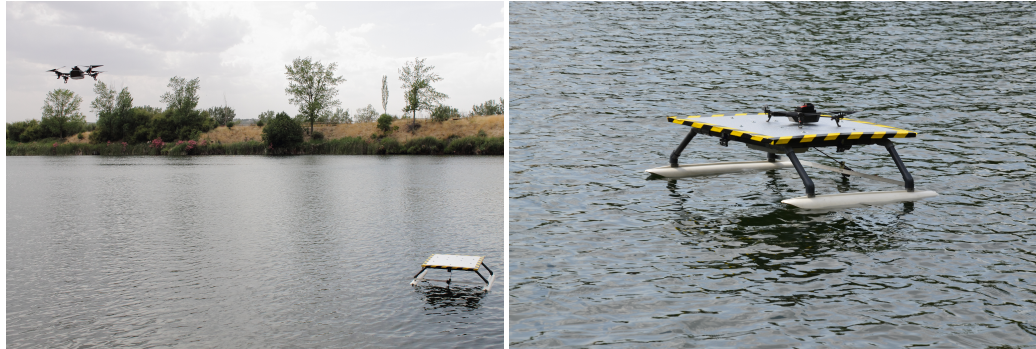
Figure 1. The above figures illustrate a possible collaborative mission between an aerial robotic system and the Strider V1.0 in a fluvial